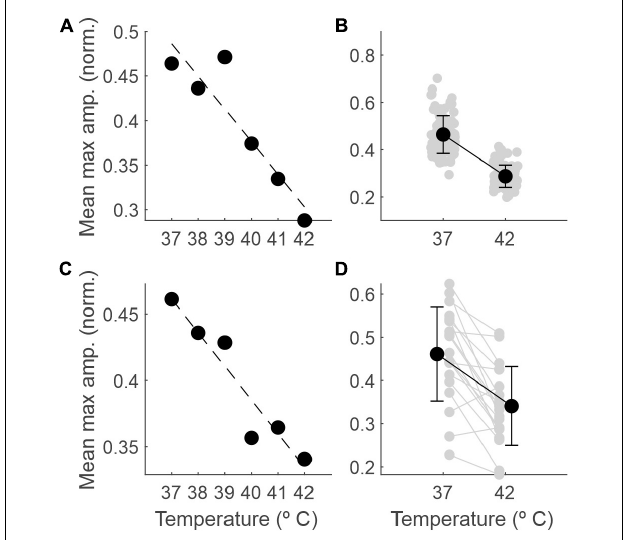
FIGURE 4 | The amplitude of the EEG decreases as the temperature increases. (A) Maximum amplitude of the normalized EEG signal within each 5-s epoch (averaged across epochs) as a function of core temperature, for one example recording session. (B) Mean and SD (black dots) and individual values for each 5-s epoch (gray dots) comparing the maximum amplitude between 37 and 42 ◦ C for the same session. (C) The same as in panel (A) , but averaged across sessions ( n = 19). (D) The same as in panel (B) but averaged across recording sessions (gray dots for individual sessions, n = 19).